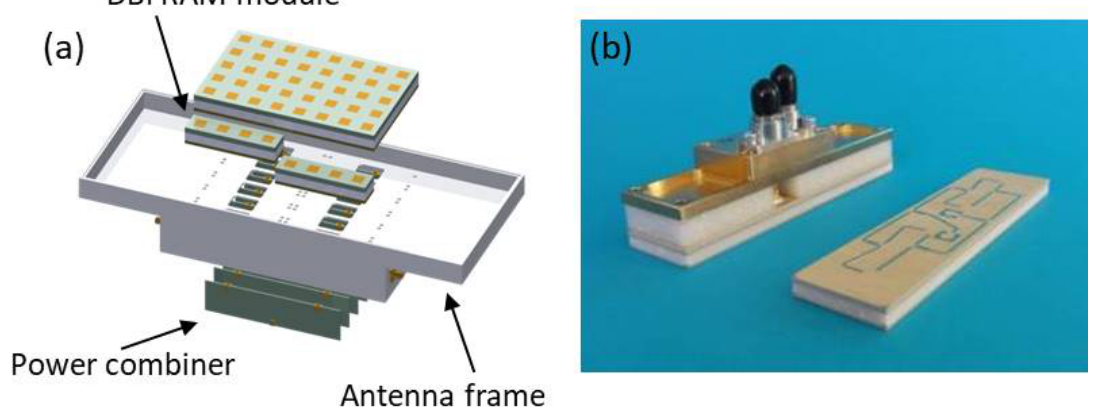
Figure 3. ( a ) Schematic representation of the DBFSAR antenna backplane, constructed to realize various DBF configurations out of a large number of DBFRAM modules; and ( b ) single DBFRAM module, containing a 1 × 4